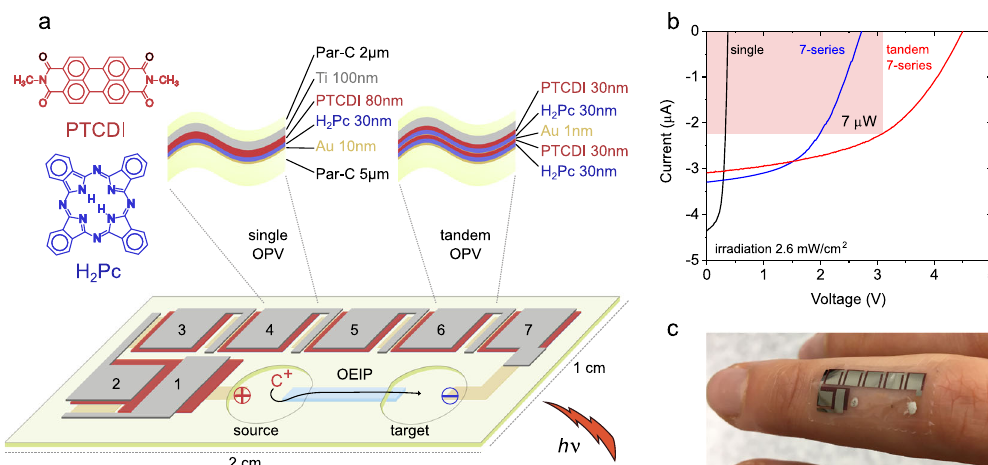
Fig. 1 Flexible organic electronic ion pumps integrated with organic photovoltaics. a Schematics of the integrated OPV and OEIP components on thin parylene-C substrates. b I( V ) curves measured for a single diode and a sevenfold series of single and tandem diodes under diffuse illumination of 2.6 mW/cm 2 at 626 nm. c The integrated device adhered on the